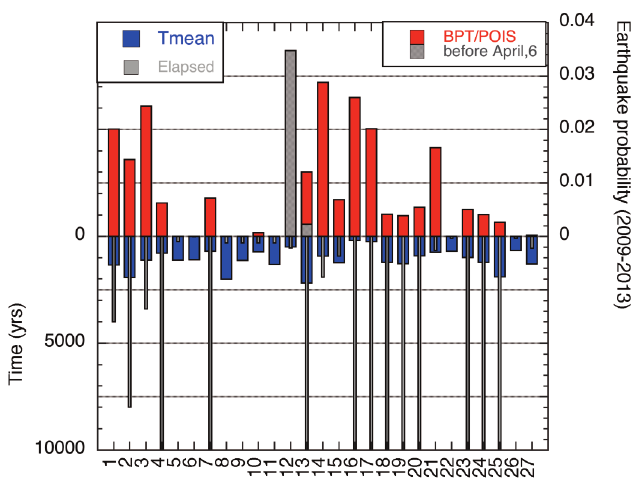
Figure 6. Earthquake probabilities (Y-axis, right) of a M event in 5 years max for the LASSCI SB sources as computed for the CSEP test. The conditional probability of occurrence in the next 5 years from August 1, 2009, were calculated using the BPT distributions for sources where time-dependency was applied (Table 2, final column), or by exponential distribution (Poisson hypothesis, memoryless) in the other cases. On the left Y-axis, the mean recurrence time and elapsed time are given (elapsed time set to 9999 years if unknown). LASSCI2009.1 (forecast on April 1, 2009) and LASSCI2009.2 (forecast on August 1, 2009) differ in terms of their source 12-Paganica (the elapsed time dropped from 548 to 0 years due to the occurrence of the L'Aquila earthquake) and source 13-Media Valle Aterno (as new paleoseismological data were made available by Falcucci et al. [2009], and the source was not treated as Poissonian any